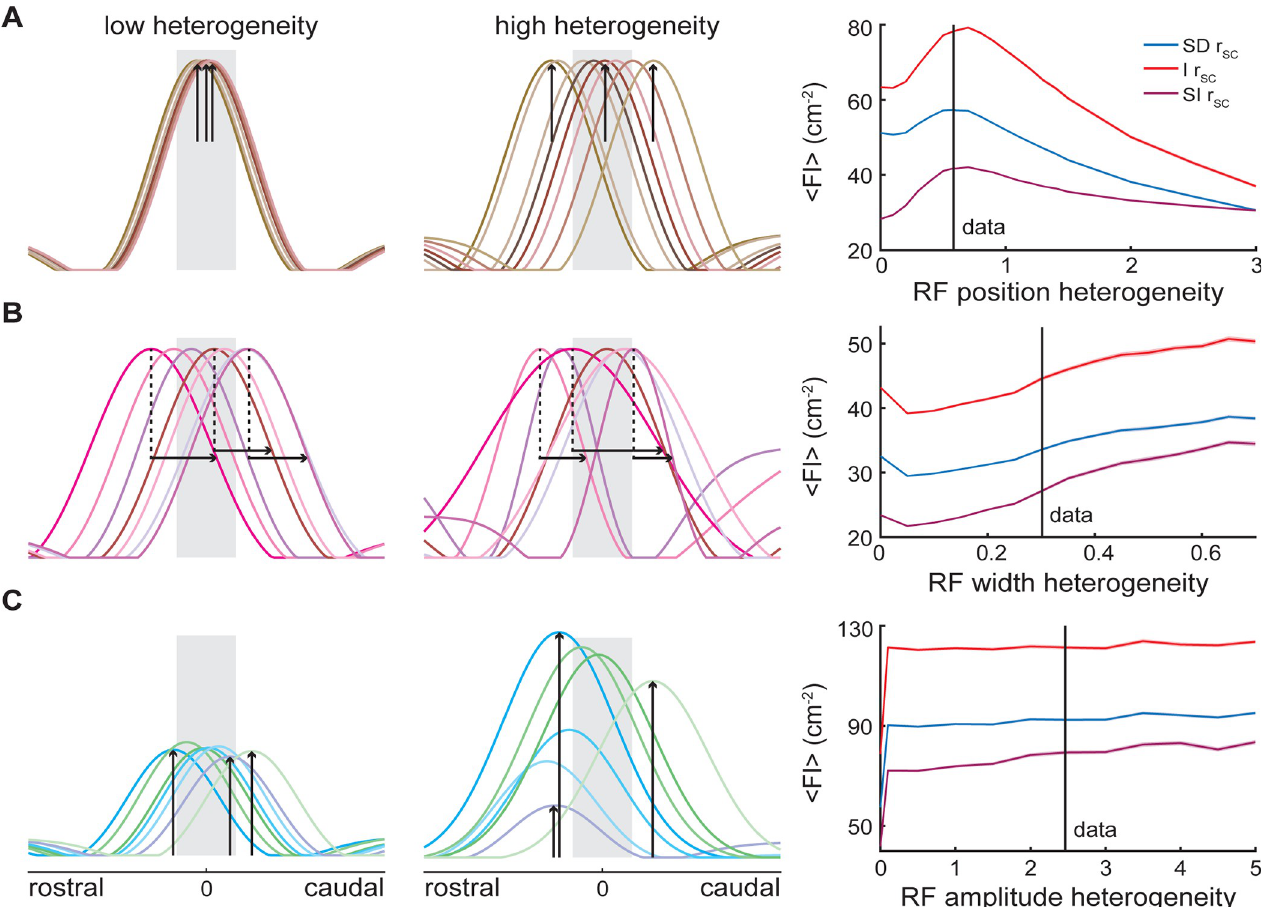
Fig 8. Receptive field heterogeneities can optimize information transmission. (A) The level of heterogeneity in terms of the receptive field position was varied from low (left) to high (middle), emphasized by the black arrows. The right panel shows the Fisher information as a function of receptive field position heterogeneity with (blue) and without (red) spatially dependent spike-count correlations, as well as with spatially independent spike-count correlations (purple). Heterogeneity was quantified as the standard deviation of the distribution from which the receptive field position for each neuron is drawn. Though small, the shaded error bars indicate the SEM. In all three correlation scenarios, the Fisher information clearly goes through a maximum as the level of receptive field position heterogeneity is increased. (B) Same as (A) but varying the level of receptive field width heterogeneity. In this case the Fisher information increases in a monotonic fashion with increasing receptive field width heterogeneity. (C) Same as (A) but varying the level of receptive field amplitude heterogeneity. In this case the Fisher information was largely independent of the level of receptive field amplitude heterogeneity.